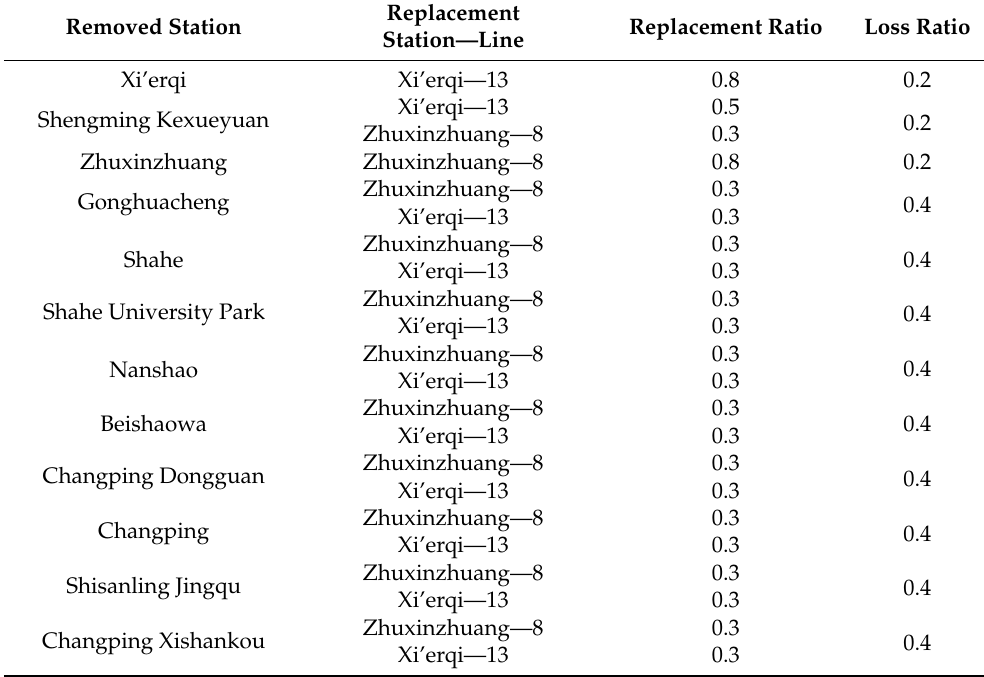
Table 3. Replacement station and proportion of passenger flow in the Changping